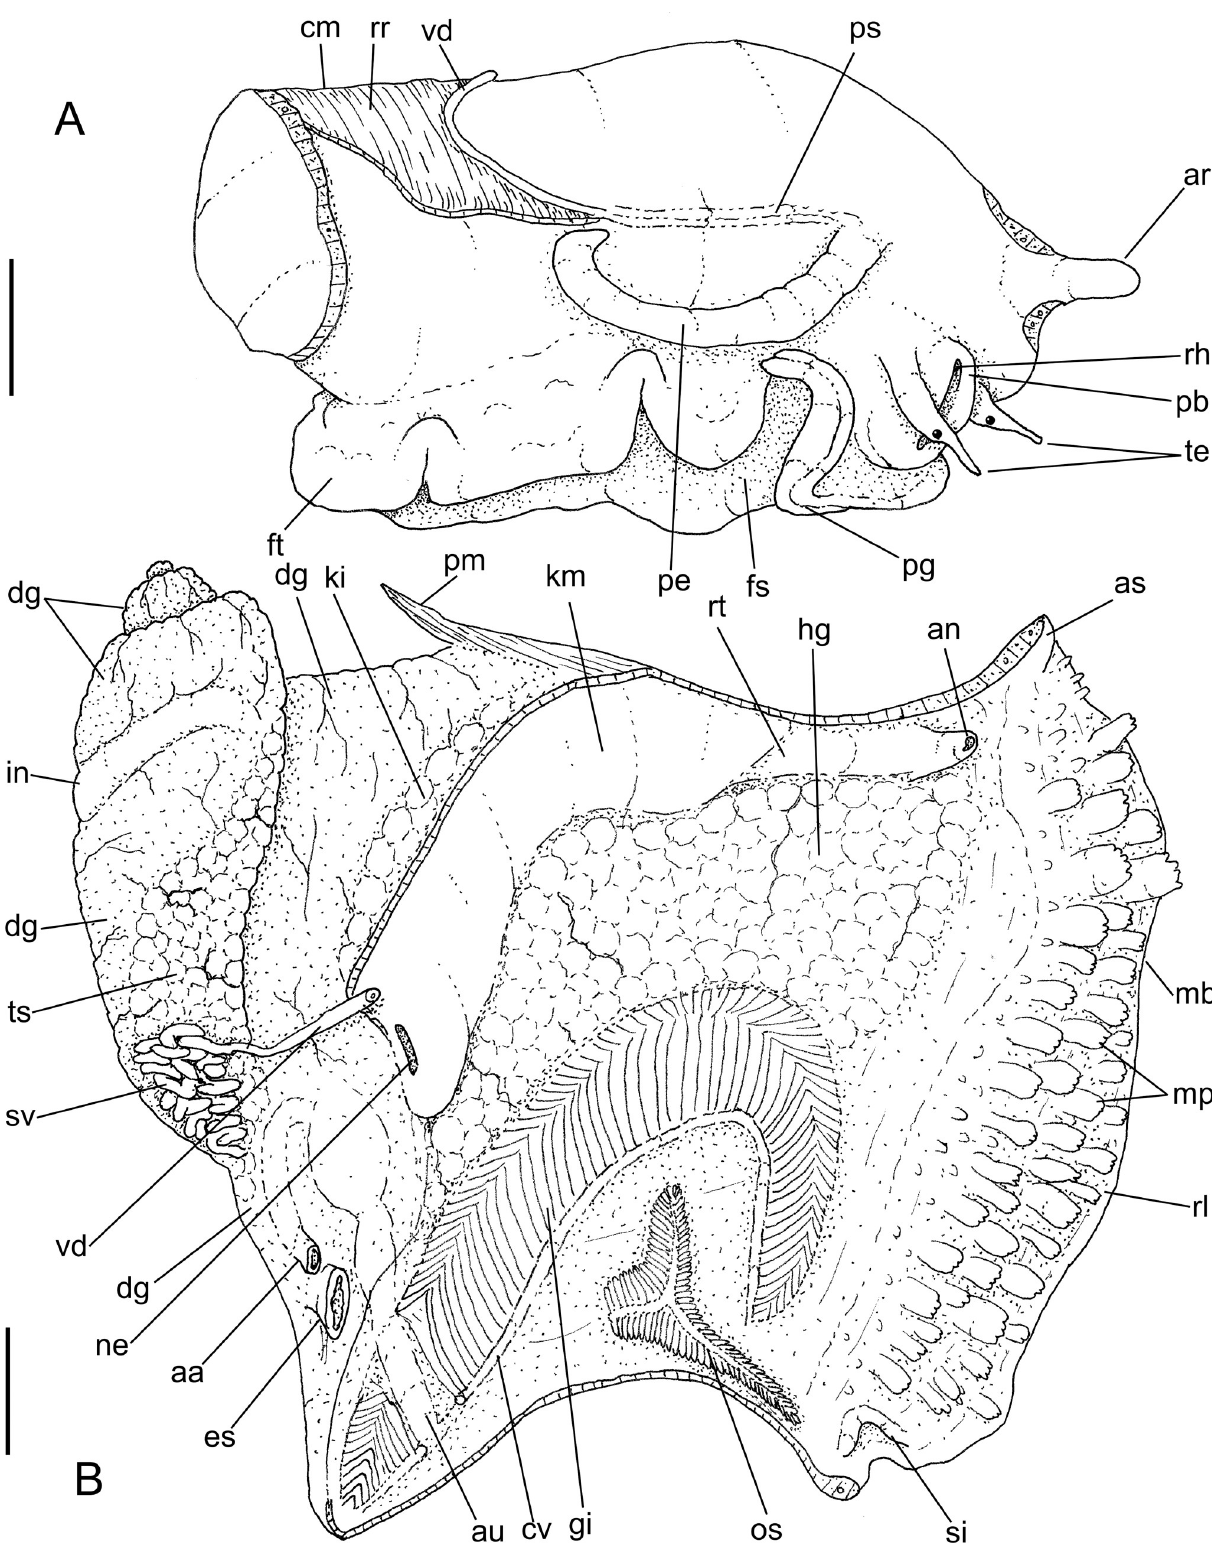
Fig 5. Macrocypraea mammoth anatomy. (A) Head-foot, male, right view. (B) Pallial roof and visceral mass, ventral view, portion of gill ventral to pericardium removed. Scales = 10 mm. https://doi.org/10.1371/journal.pone.0225963.g005 PLOS ONE | https://doi.org/10.1371/journal.pone.0225963 January 8,